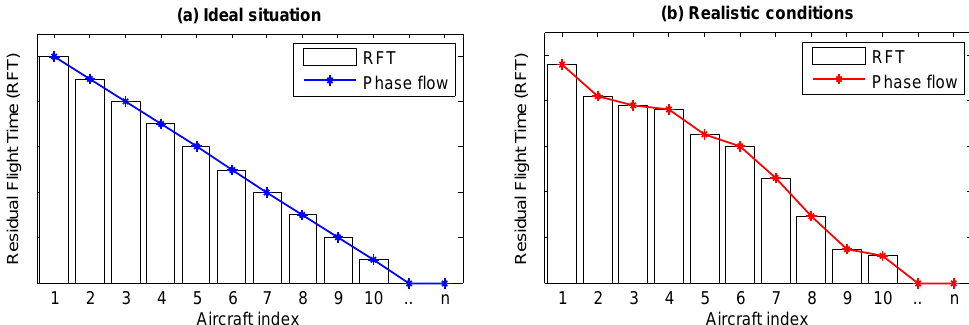
Figure 1. Ideal ( a ) and realistic ( b ) examples of a phase flow chart for a fleet consisting of n aircraft. Reprinted from [3].